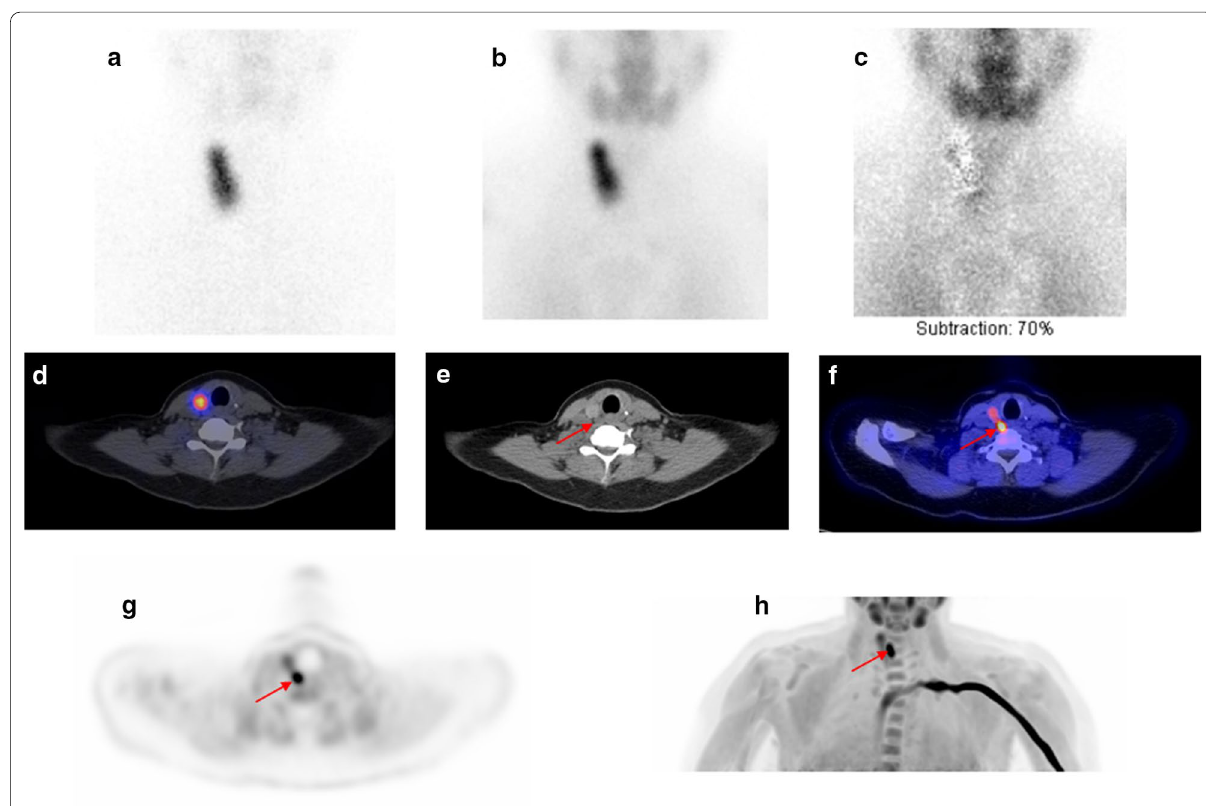
Fig. 2 Patient example of a negative 99m Tc-MIBI-SPECT/CT and a positive 11 C-choline PET/CT. Previously, the patient underwent a hemithyroidectomy on the left side because of a thyroid nodule, which proved to be benign. Planar anterior image of the neck with 99m Tc-pertechnetate ( a ) and early 99m Tc-MIBI ( b ) showing physiological uptake in the right thyroid lobe. Planar subtraction image (early 99m Tc-MIBI minus 99m Tc-pertechnetate image c ) also does not show the parathyroid adenoma. The uptake in the right thyroid lobe was also observed on the 99m Tc-MIBI-SPECT image d . The low dose-CT of the 99m Tc-MIBI-SPECT/CT e retrospectively did show a focus suspect for a parathyroid adenoma located paraoesophageally on the right side (red arrow). The 11 C-choline PET/CT ( f fused PET/CT image and g , h PET only image) showed this same lesion (1.80 cm and 1.00 g at pathology) located paraoesophageally on the right side, suspicious for a parathyroid adenoma (red arrow). The 11 C-choline PET/CT also showed the same physiological uptake in the right thyroid lobe ( f – h )